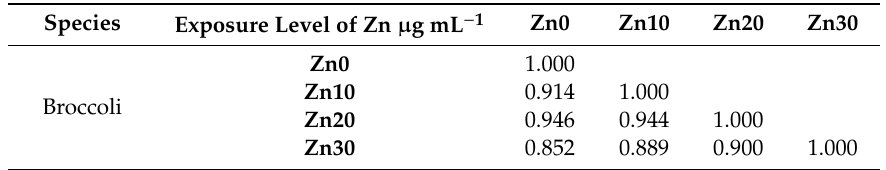
Table 4. Similarity matrix of broccoli, sunflower and pea samples generated on the basis of RAPD analysis using Jaccard similarity coe ffi cient. Sprouts of all species were obtained via enrichment of seeds with Zn0, Zn10, Zn20 and